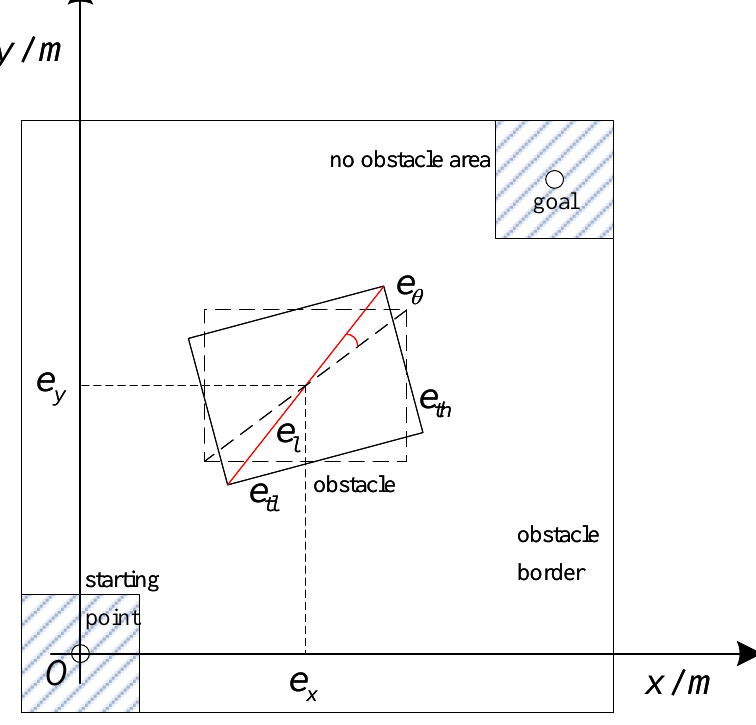
Figure 2. Environment schematic.